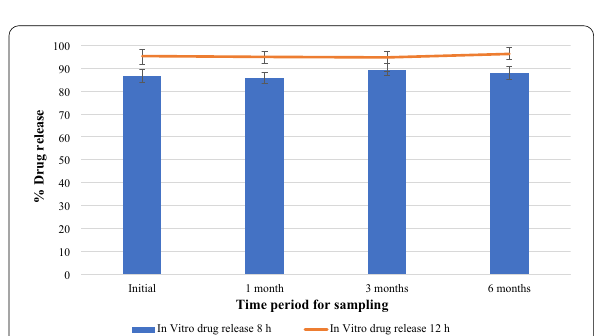
Fig. 9 Stability study for cumulative % drug release study of pirfenidone